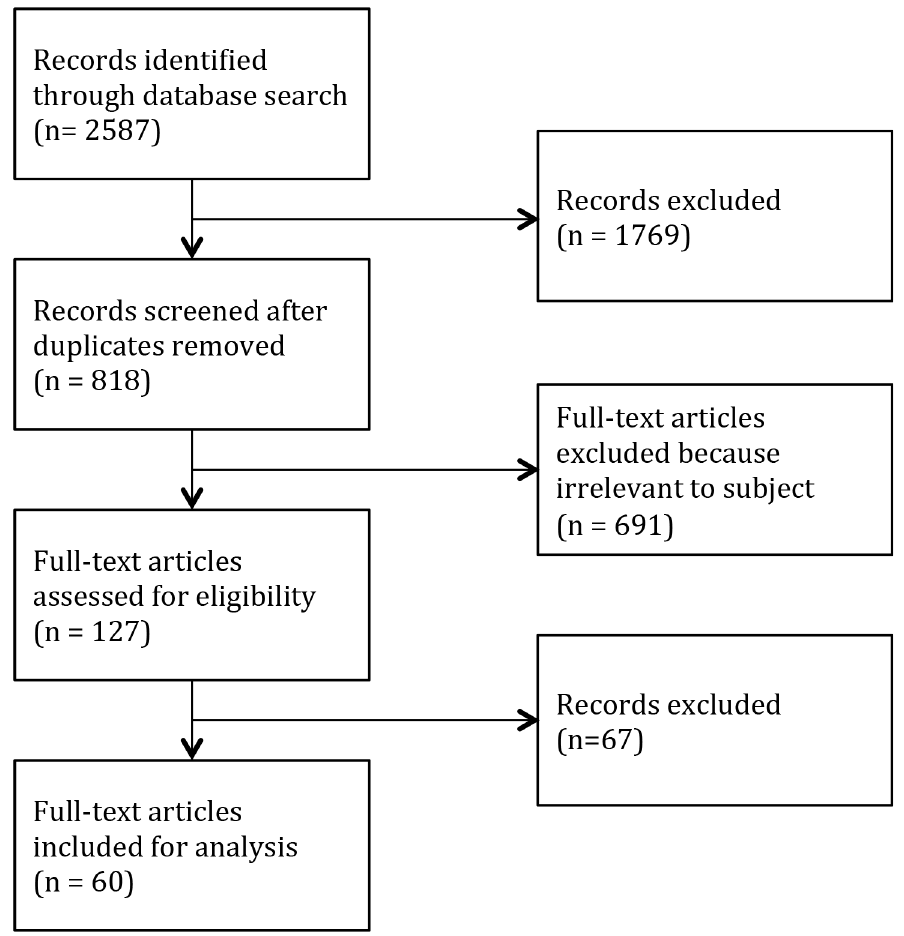
Fig 1. Flow diagram of search strategies for eligible